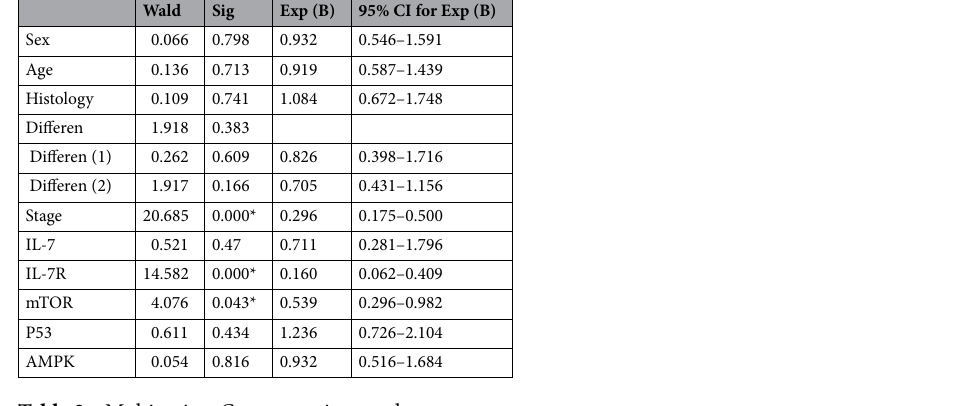
Table 3. Multivariate Cox regression